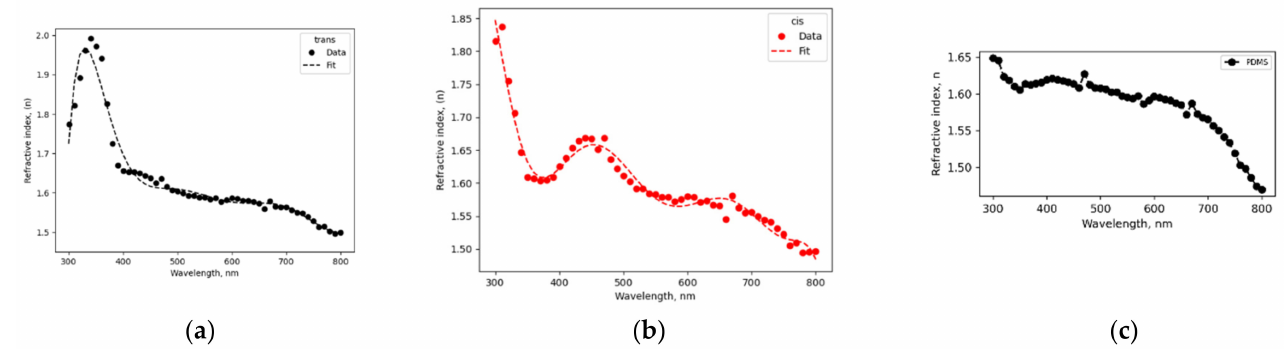
Figure 1. Refractive indices of polydimethylsiloxane–arylazopyrazole (PDMS–AAP) composite at ( a ) trans state and ( b ) cis state; ( c ) pure